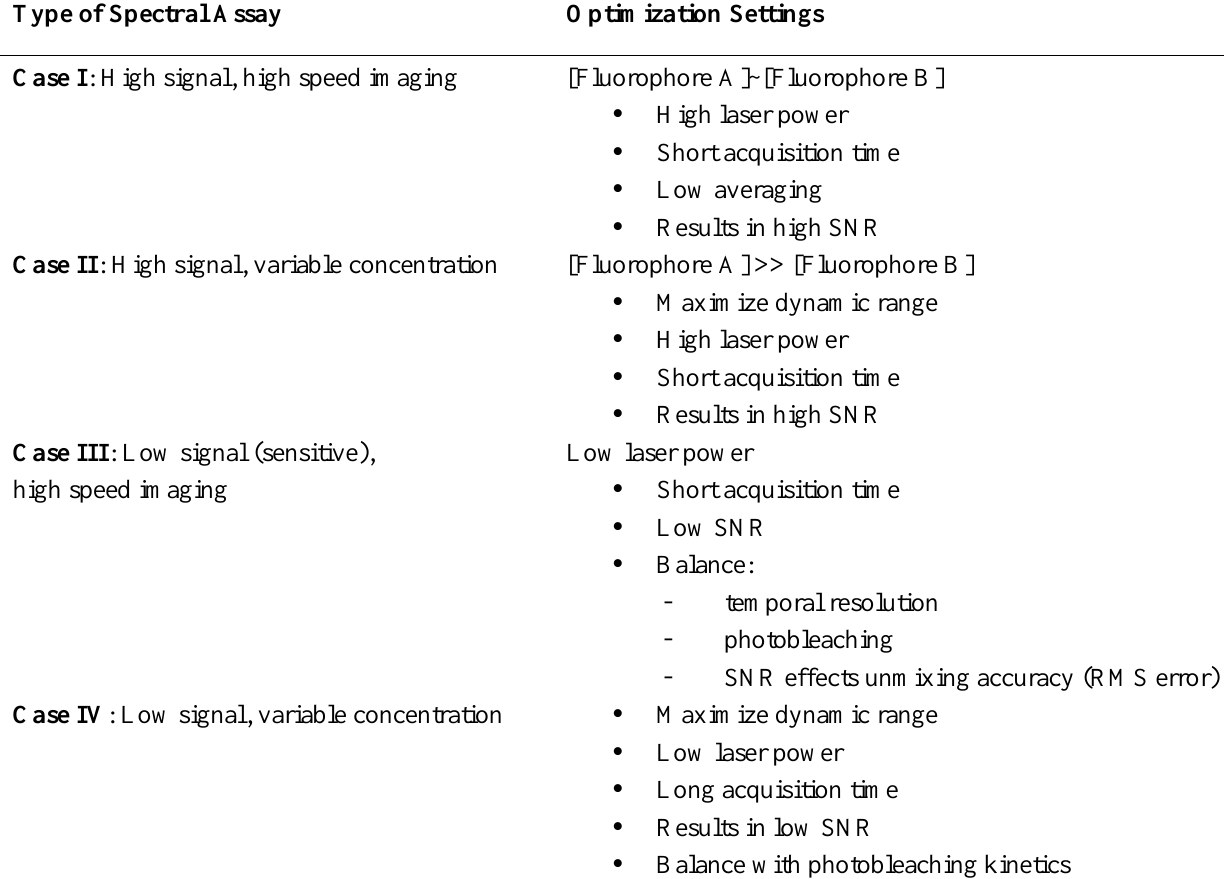
Table 3. General classes of fluorescence hyperspectral imaging assays and optimal operating